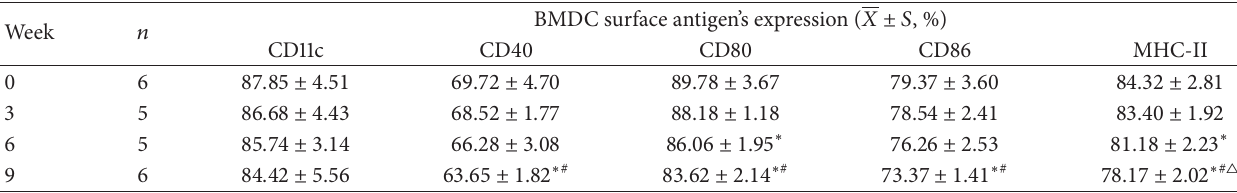
Table 3: BMDC surface antigen’s expression of MTX group.